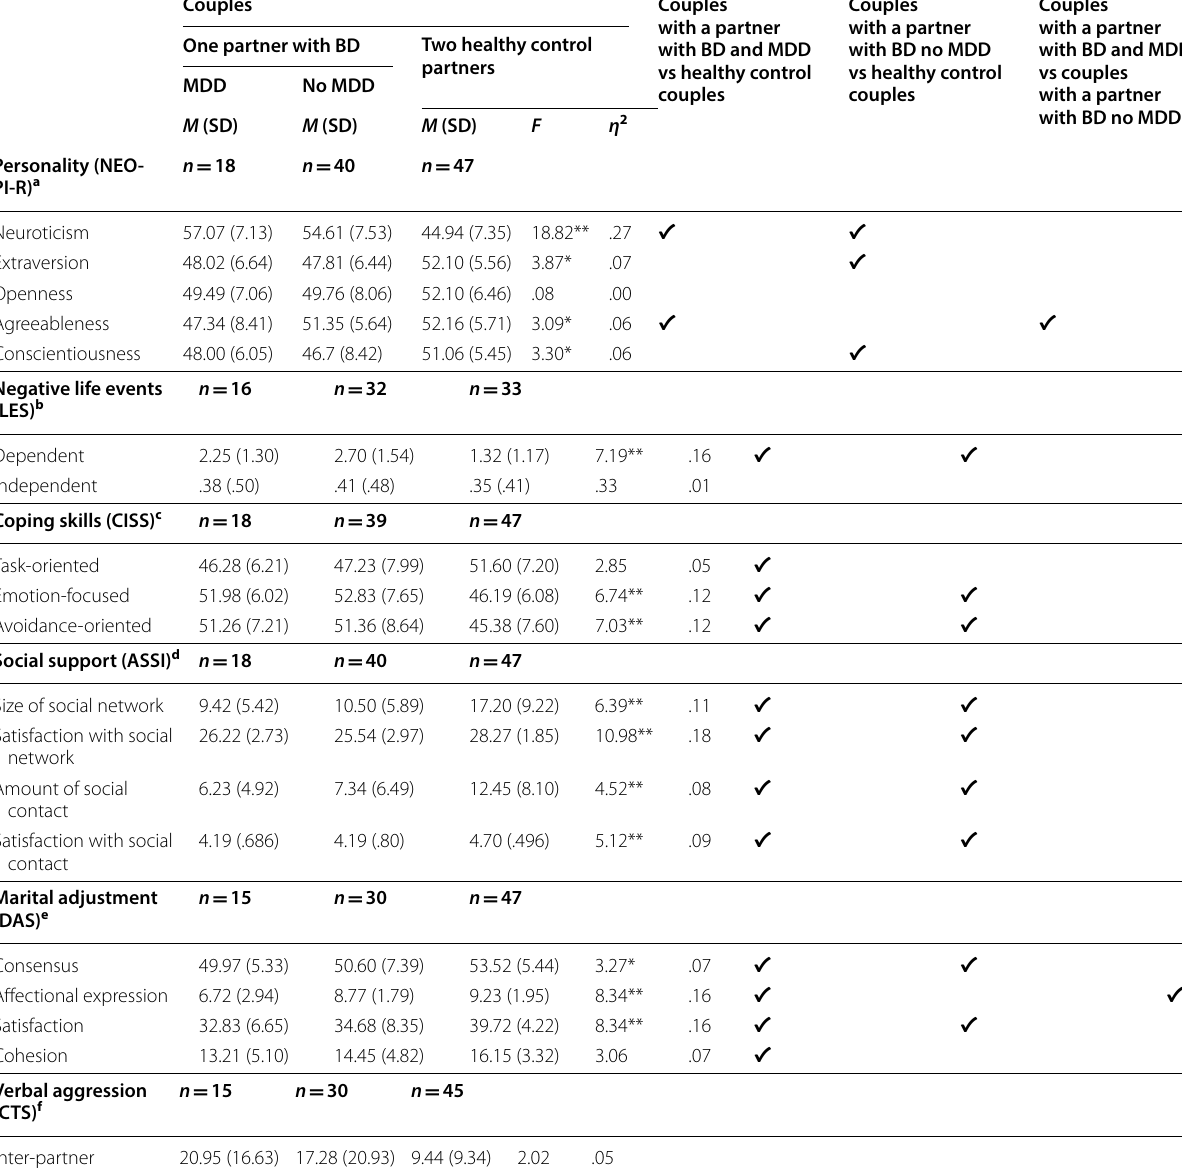
Table 4 Comparisons of personality traits and psychosocial functioning of couples in which one partner presents BD and the other major depression, couples in which one partner presents BD and the other no major depression, and healthy control